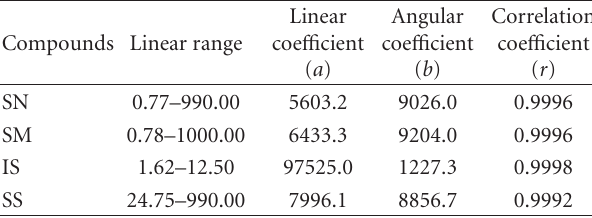
Table 2: Linear regression to quantify glycoalkaloids. Compounds Linear range